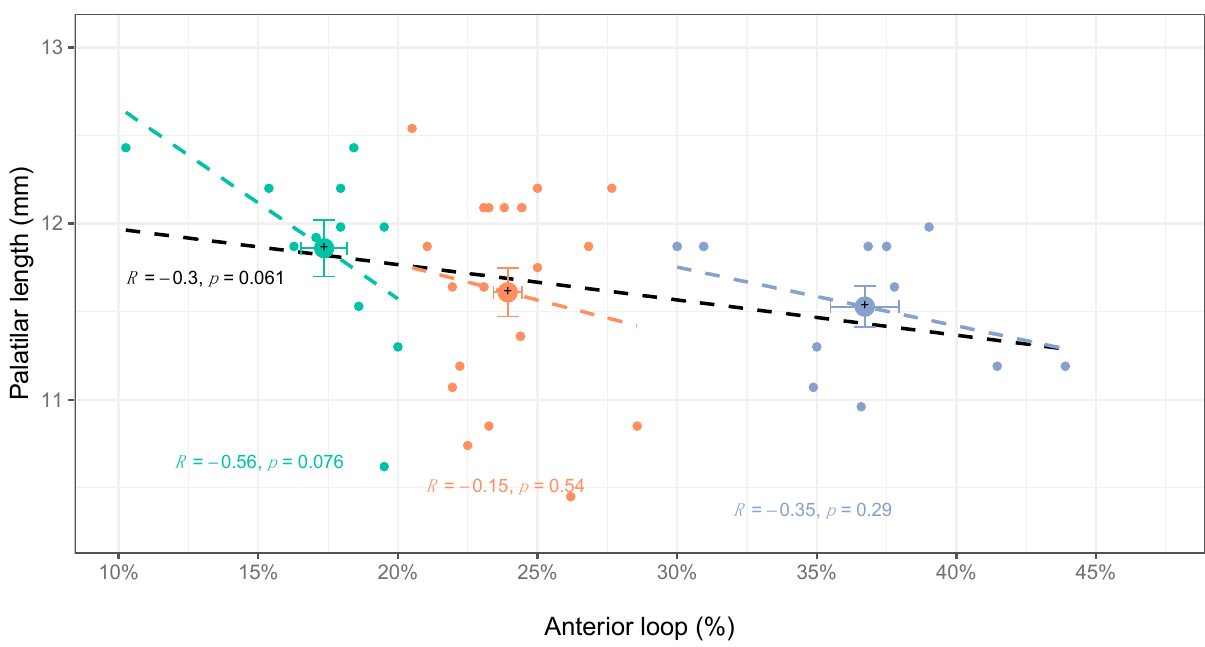
Figure 6. Regression and correlation analysis of palatilar lengths (mm) and the anterior loop percentages among the m 1 groups. The largest points (+) depict the centroids of each group with the standard errors for both variables. The black line represents the common regression line while the coloured ones, those of each individual group.